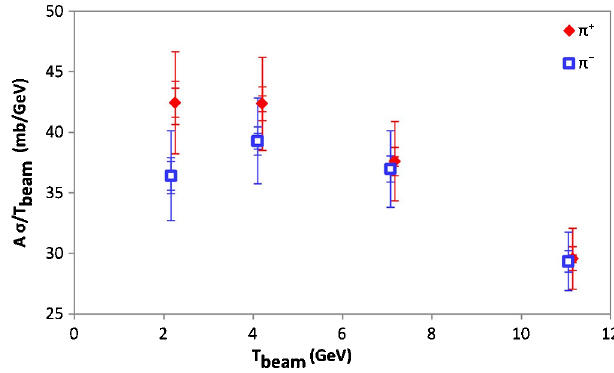
4. Acceptance-weighted cross sections, divided by beam energy, for (cid:3) þ and (cid:3) (cid:1) production by protons off of tantalum, using data from the HARP group. The points for (cid:3) þ and (cid:3) (cid:1) have been displaced, respectively, left and right by 50 MeV for clarity of